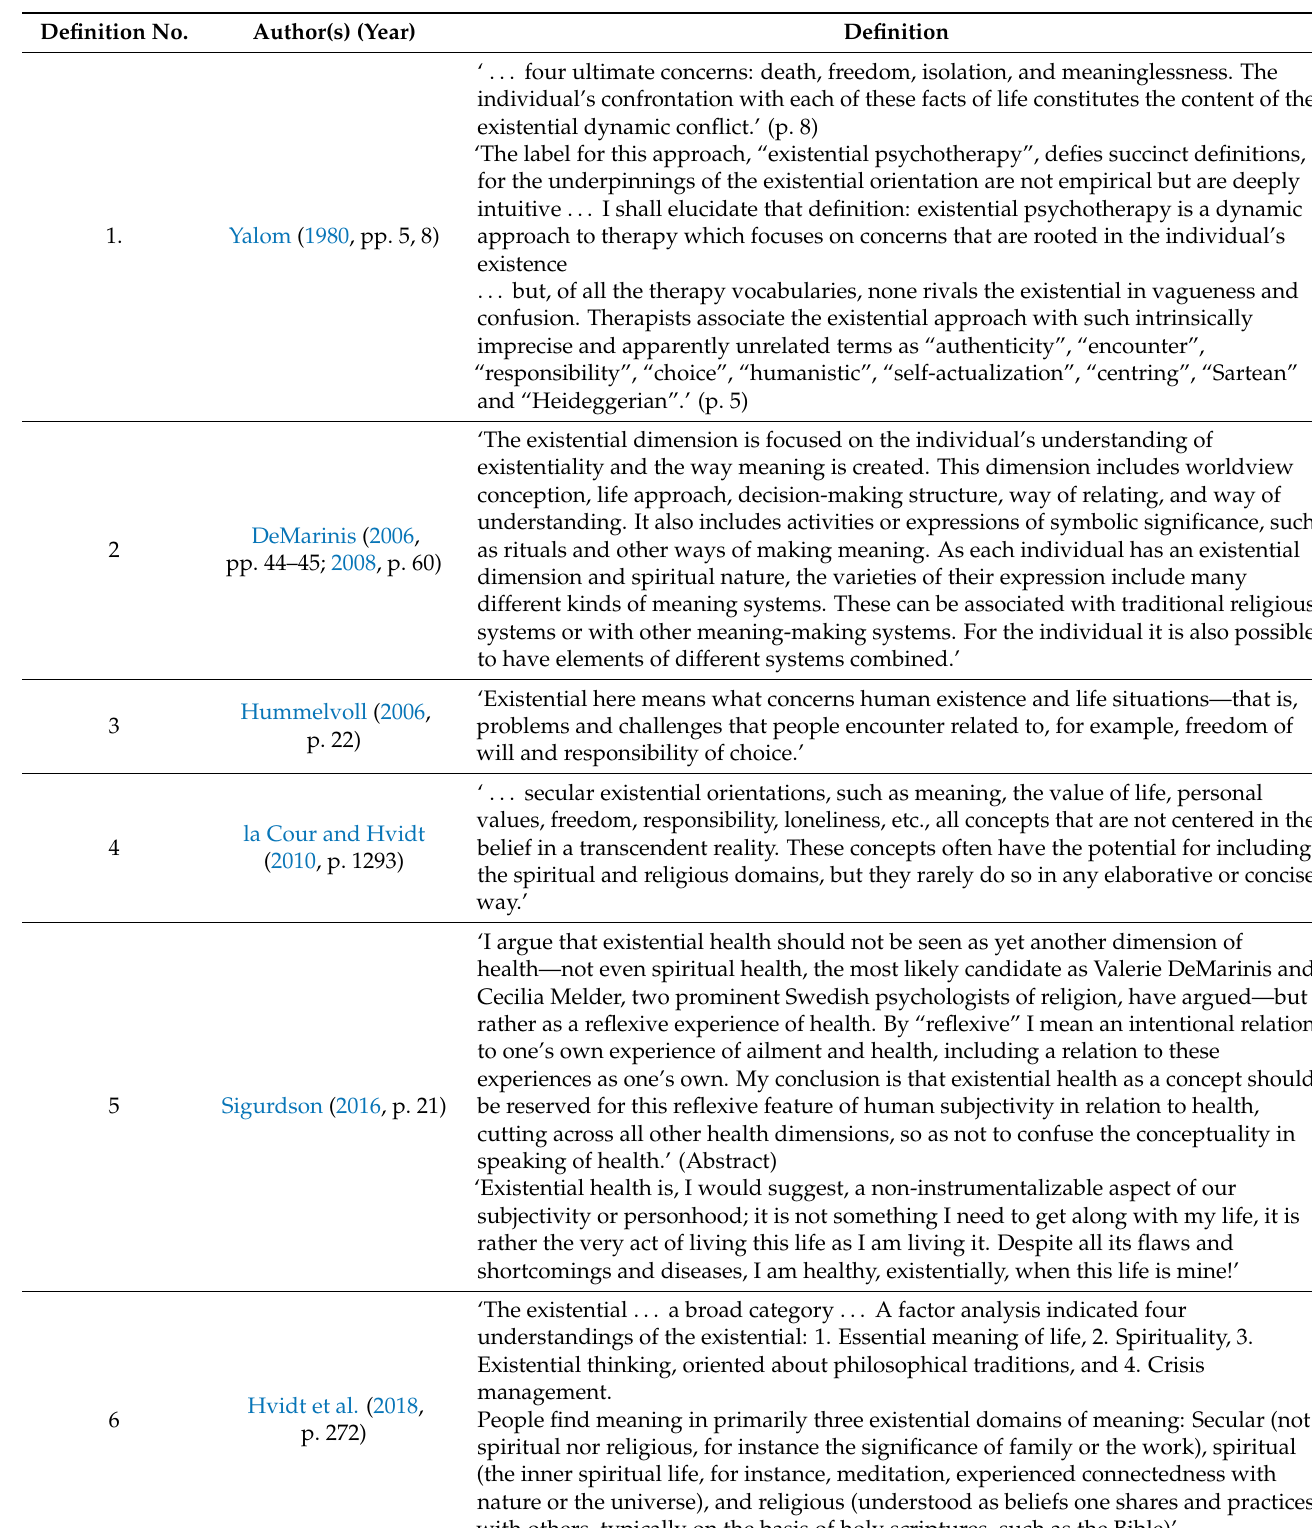
Table 2. Definitions of ‘existential’ included in the